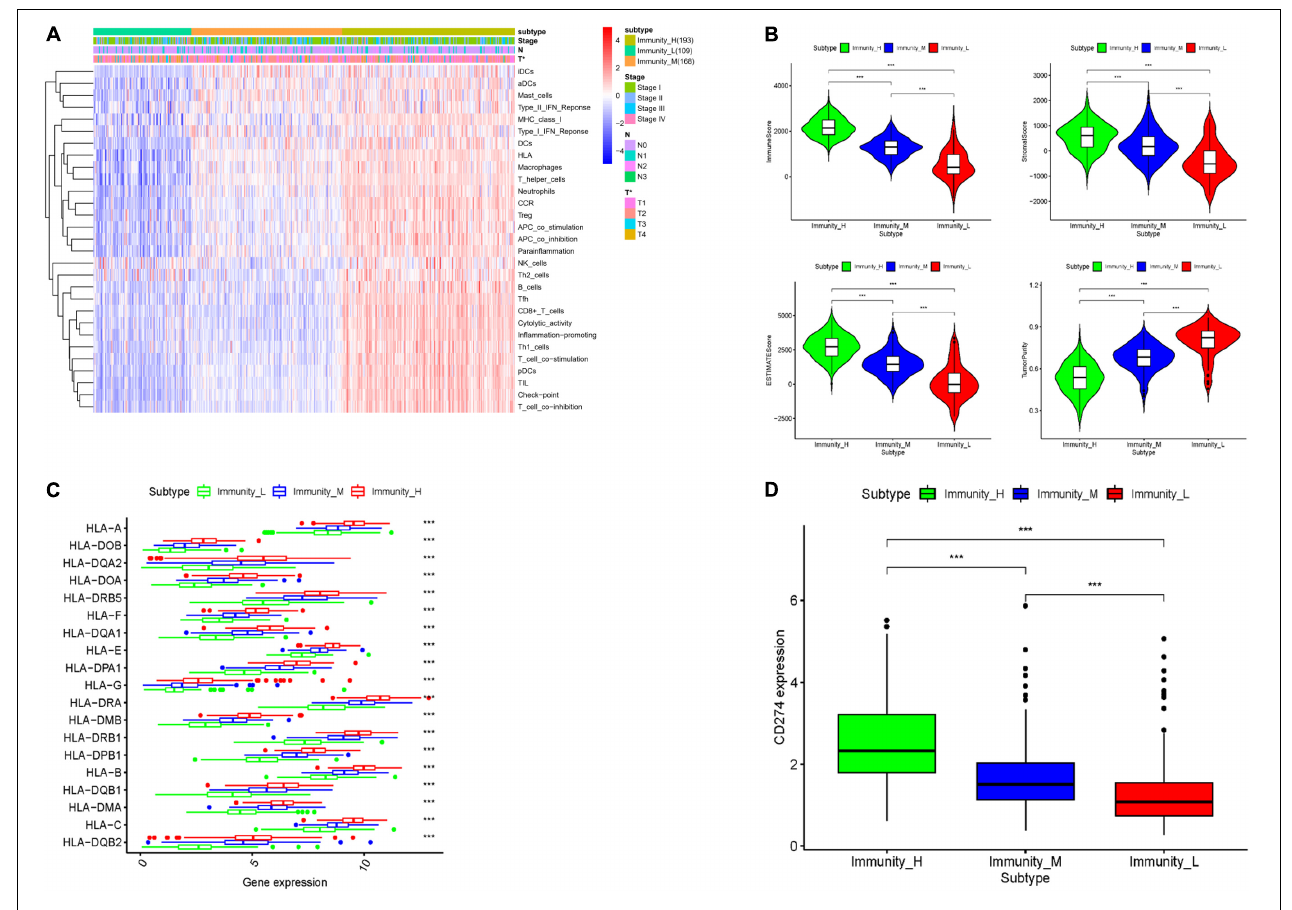
FIGURE 3 | Validation of grouping effect of LUAD tissue samples. (A) Samples were divided into Immunity_H, Immunity_M, and Immunity_L groups according to immunological competence from high to low. Heatmap shows ssGSEA enrichment value of each immune-related gene set of LUAD tissue in each group, and tumor purity, immune score, stromal score, and ESTIMATE score obtained by “ESTIMATE” analysis. (B) Violin plots of tumor purity, immune score, stromal score, and ESTIMATE score of three groups of LUAD tissue. (C) Boxplots of the expression of each HLA family gene in LUAD tissue in three groups. (D) Boxplots of the expression of CD274 gene in LUAD tissue in three groups. *** represents p < 0.001 (difference between groups is highly statistically significant).